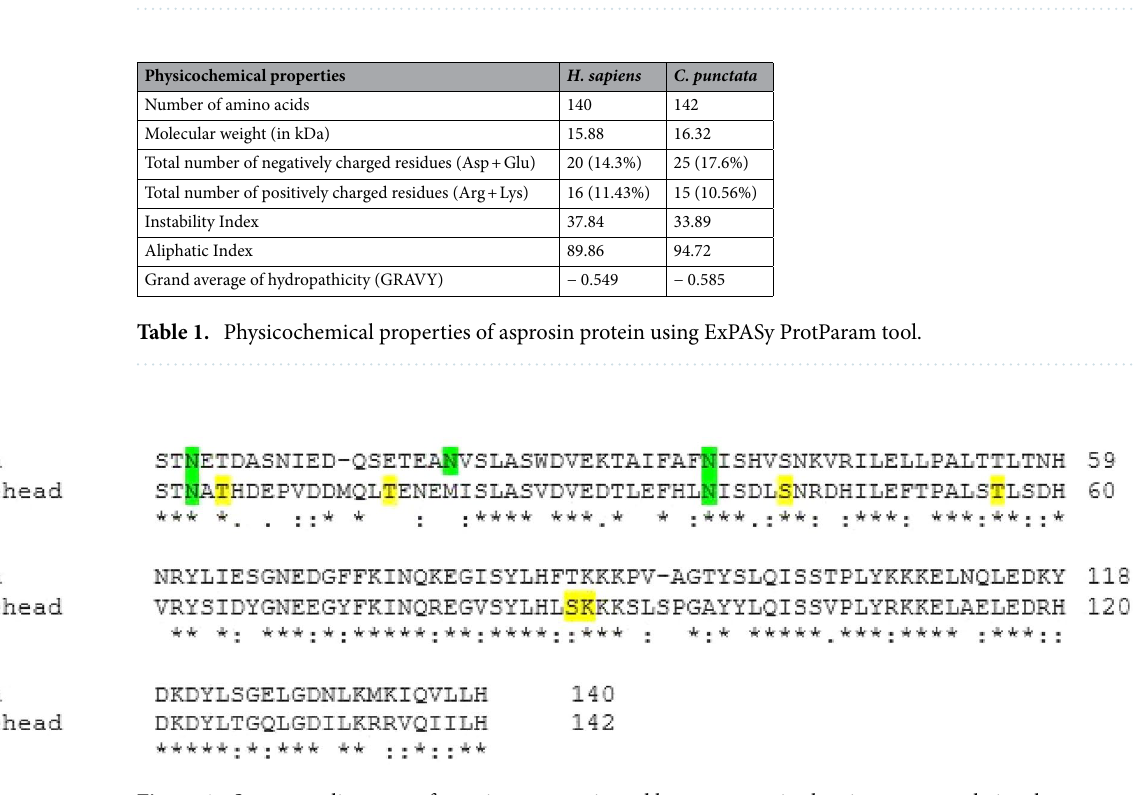
Figure 4. Sequence alignment of putative ss asprosin and human asprosin showing post-translational modifications. The glycosylation sites are highlighted in green and phosphorylation sites are highlighted in